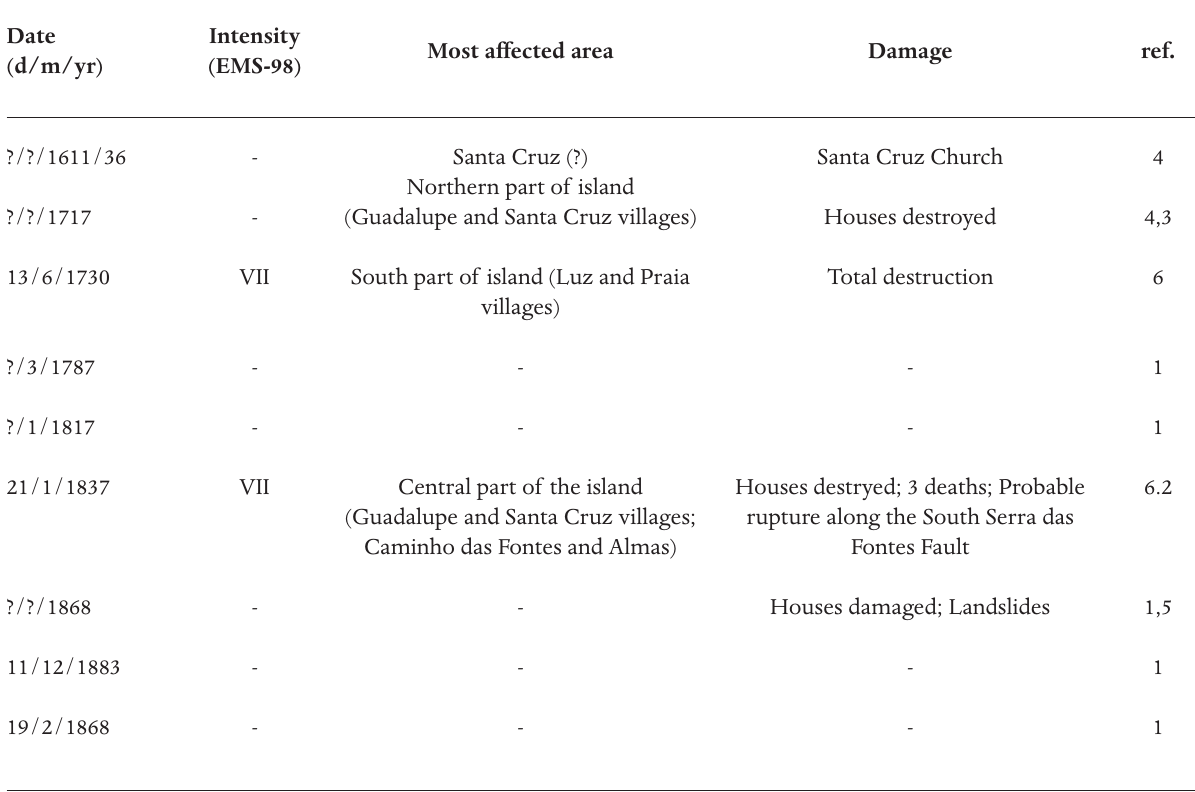
Table 2. Historical seismicity in Graciosa Island (Modified from Gaspar [1996]). References: 1. Moniz [1883], 2. Arquivo dos Açores [1890], 3. Matos [1982],, 4. Pereira [1986], 5. INMG/LNEC [1986], 6. Silva